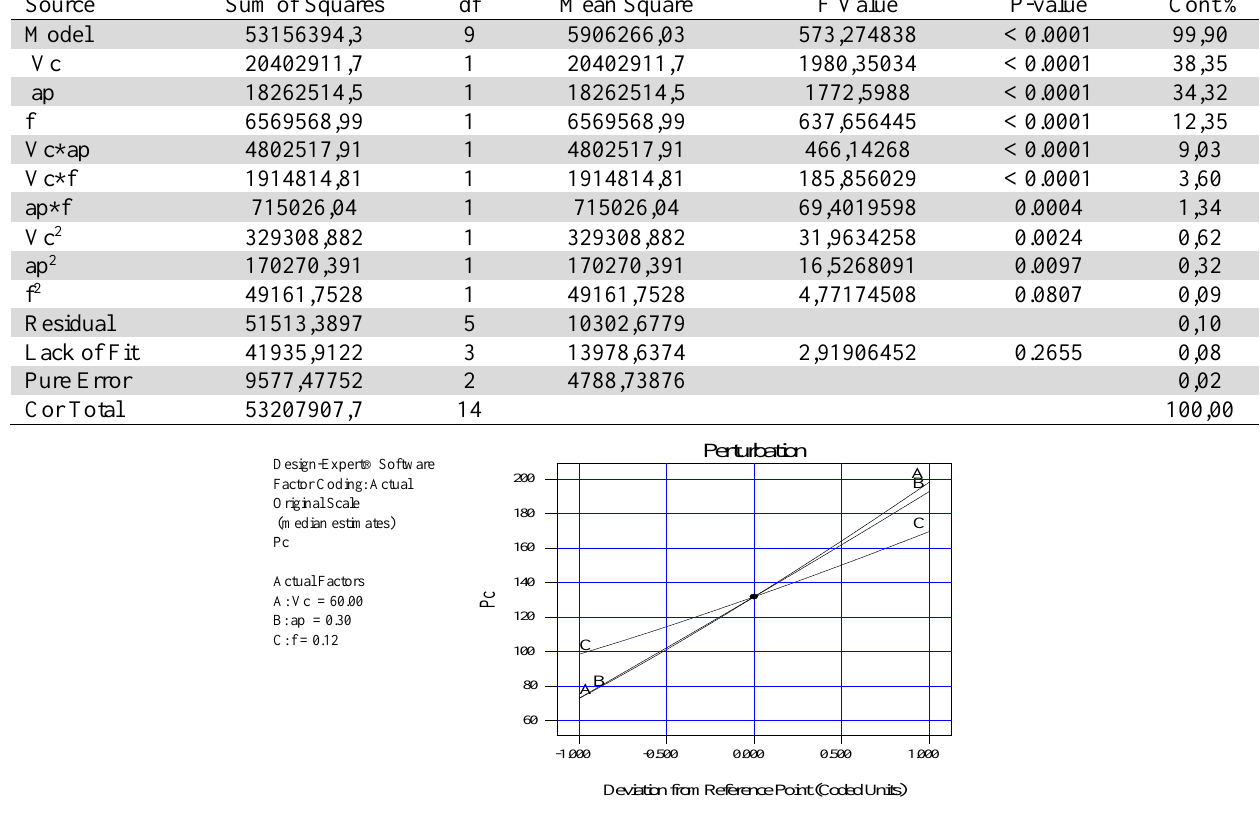
Fig. 10. Perturbation plot for Pc